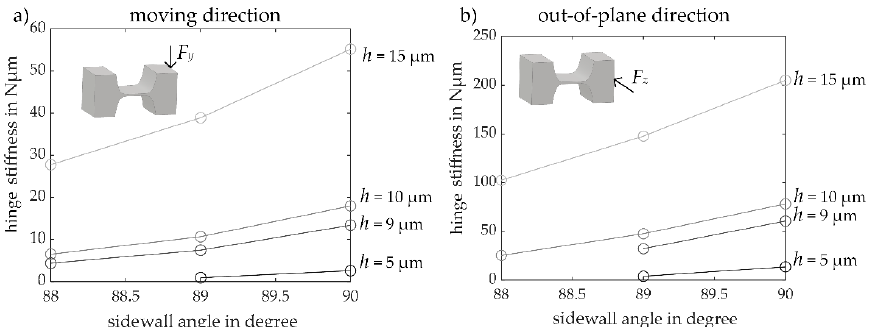
Figure 9. Dependence of the etching quality on the single flexure hinge stiffness, ( a ) in direction of motion and ( b ) in out-of-plane direction.